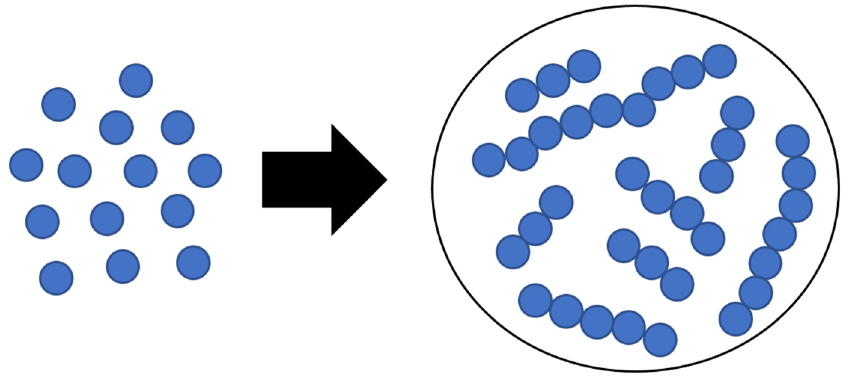
Figure 3. Schematic representation of G-actin monomers ( left ) that polymerize into many different actin filament lengths ( right ). This accounts for the polydispersity that we encounter in a real